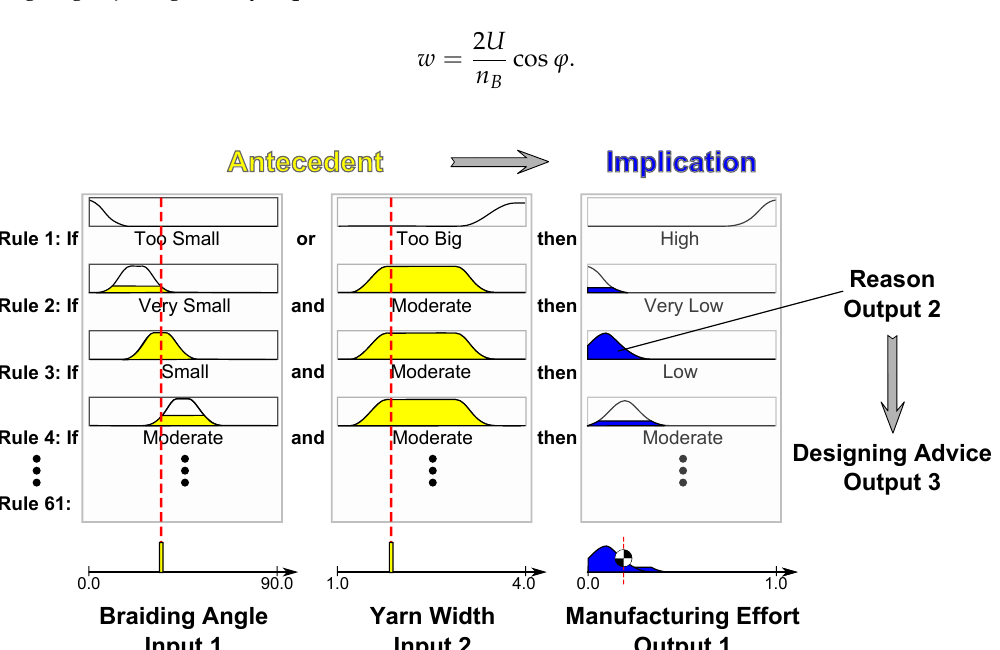
Figure 7. Projection of braiding angle ϕ and yarn width w to manufacturing effort e